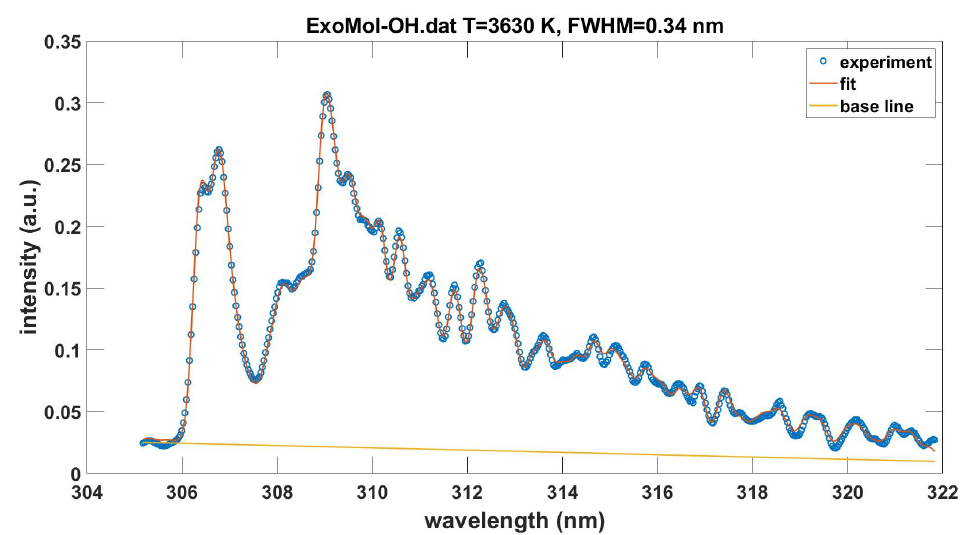
Figure A2. Measured and with ExoMol-OH.dat fitted OH emission spectra, ∆ v = 0, δ λ = 0.34nm, T = 3.63kK.